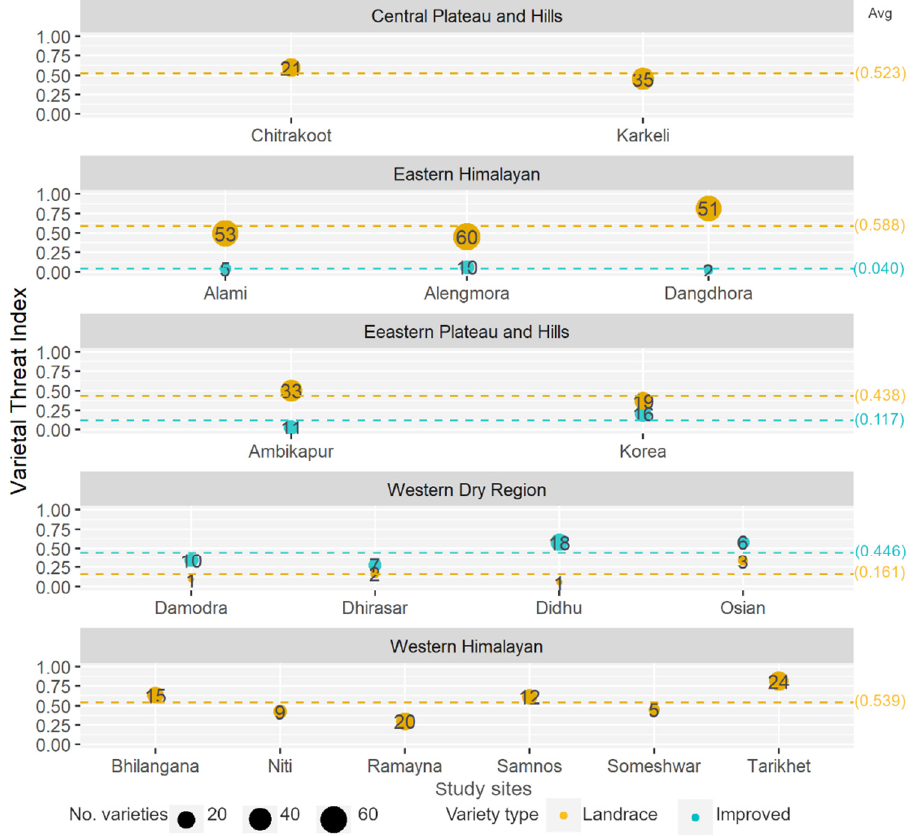
Figure 5. Varietal Risk Index at the agroecological and site level as well as by variety type. Numbers indicate the number of varieties. Average values per variety type are reported in parentheses on the right side of the figure.